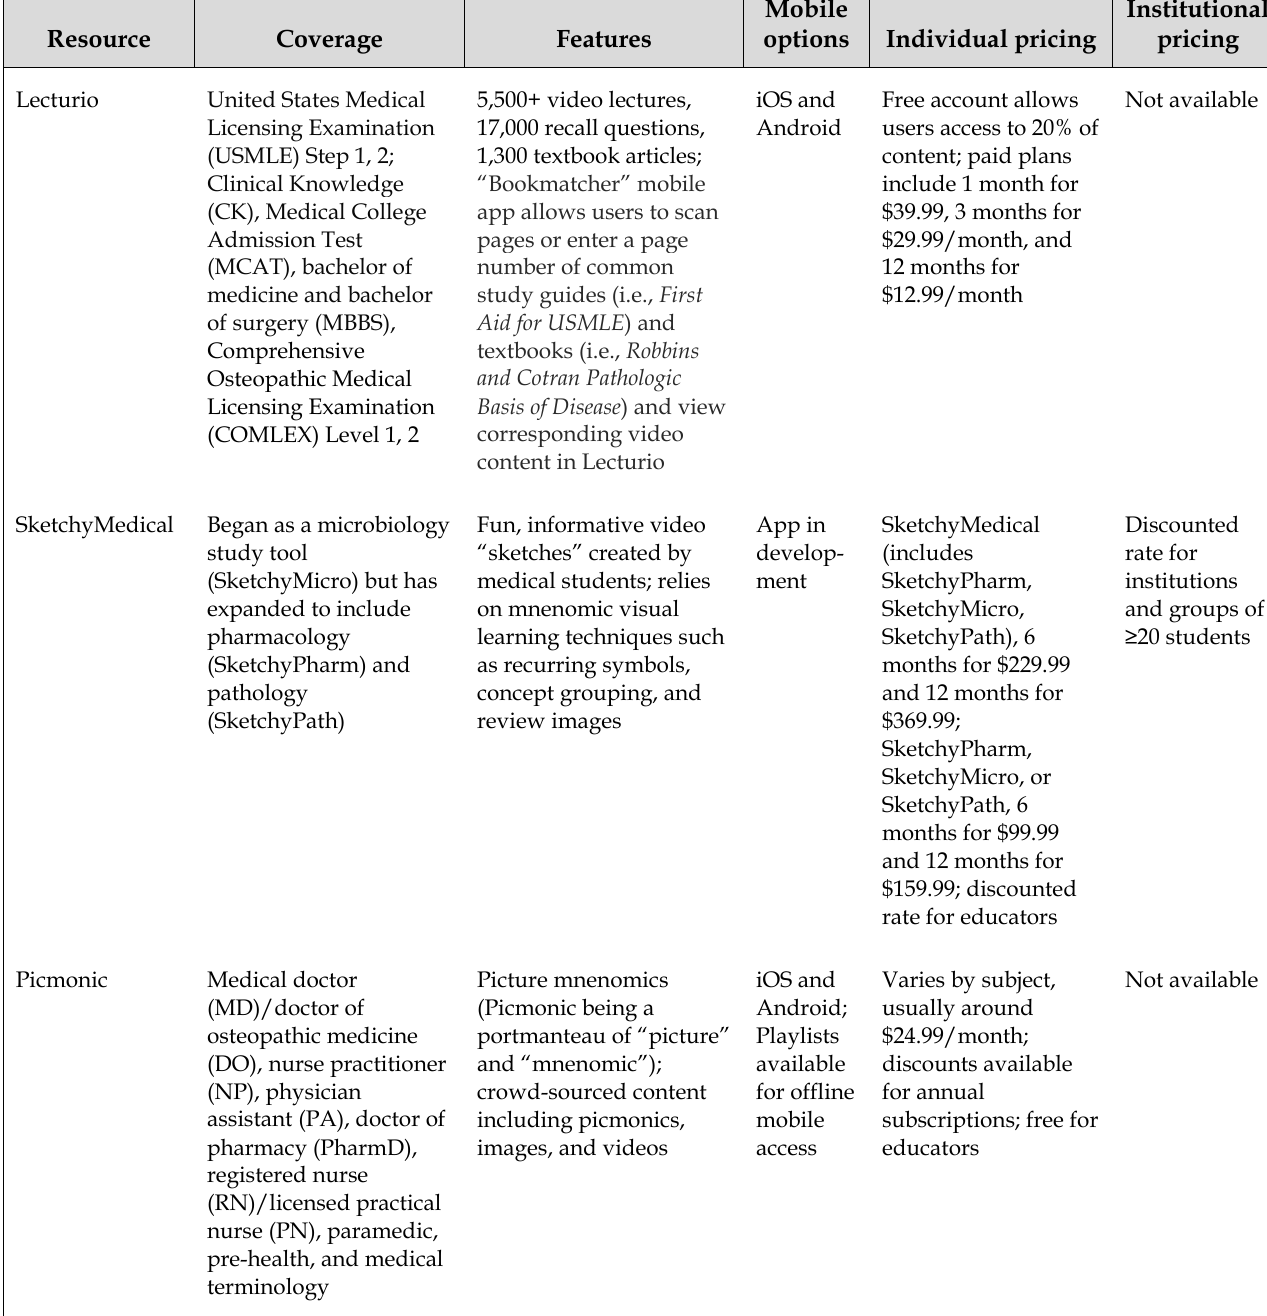
Table 1 Proprietary study resources in medical education